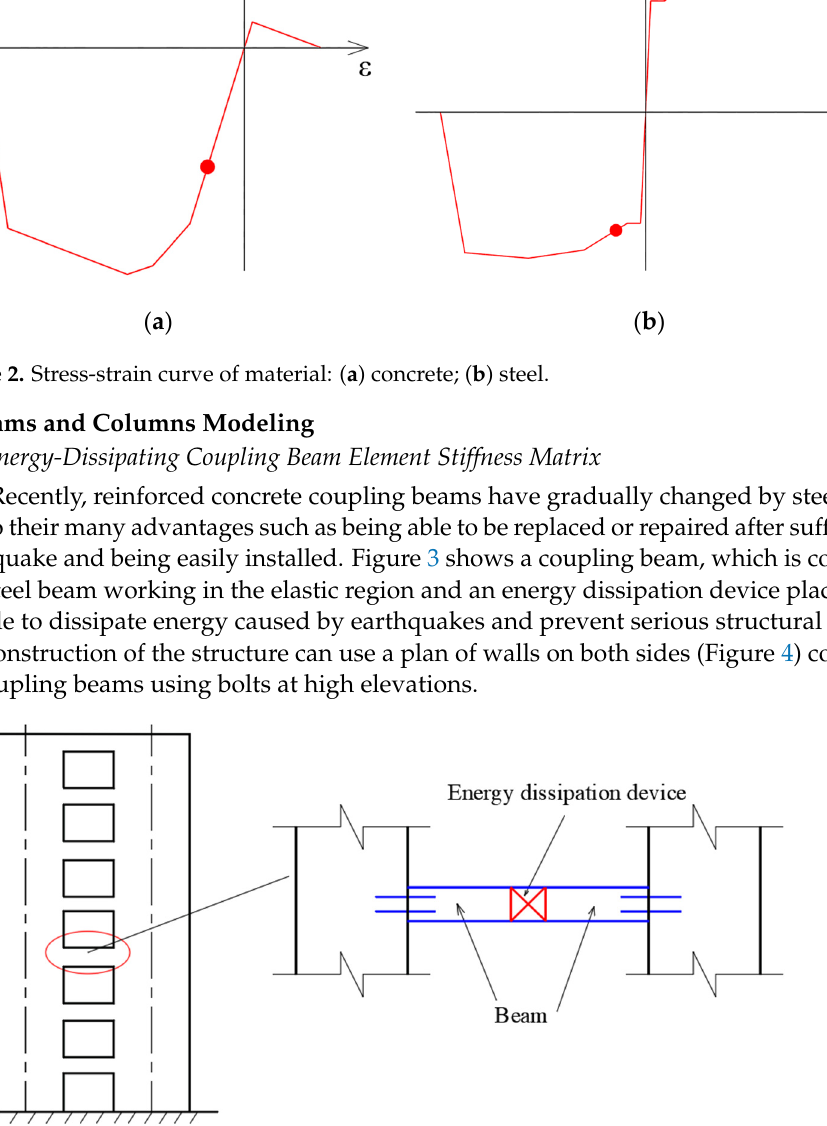
Figure 1. Material hardening laws: ( a ) Stress-strain curves; ( b ) Kinematic hardening.